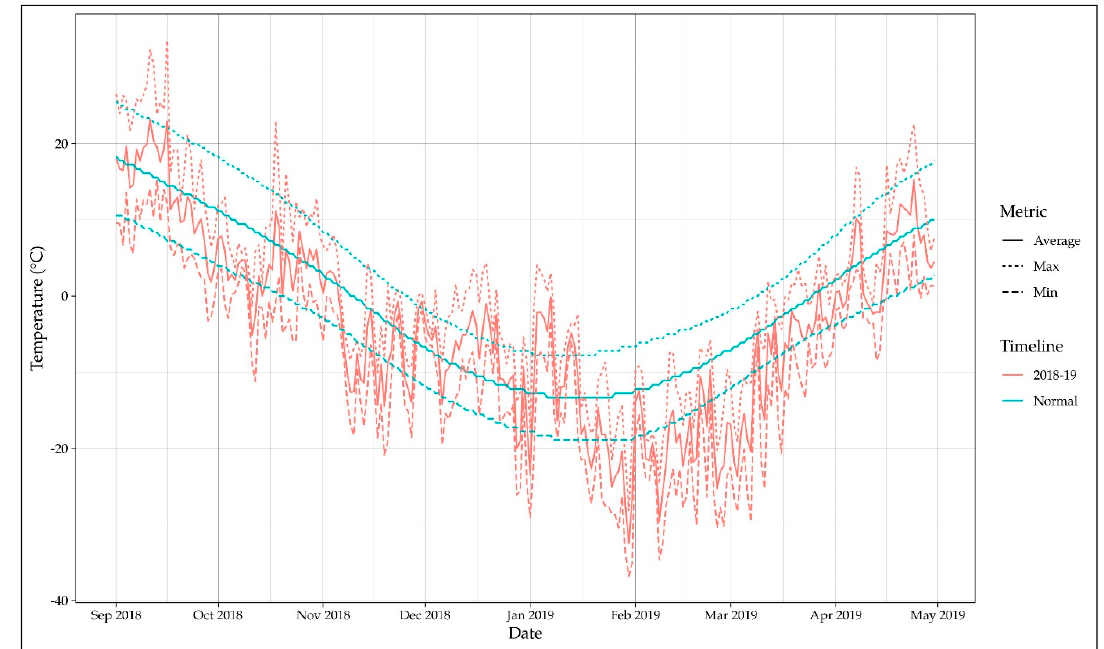
Figure 1. Normal (1971–2000) daily temperatures and temperatures from September 2018 to May 2019 recorded at the North Dakota Agriculture Weather Network weather station near Prosper, ND USA.